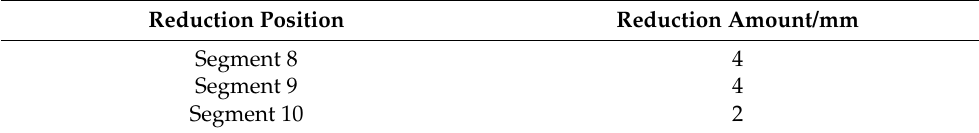
Figure 12. The solid fraction of slab center: ( a ) the end of segment 7; ( b ) the end of segment 8; ( c ) the end of segment 9. Table 6. The soft reduction parameters after